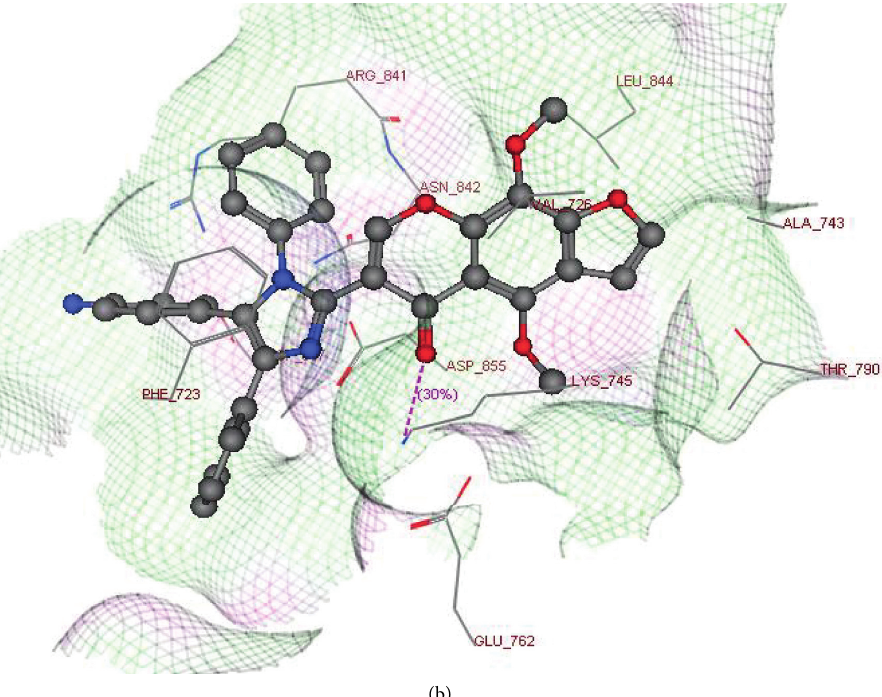
Figure 4: (a) The 2D depiction of the docked conformation of 5c in the EGFR protein (PDB ID: 5CAV) binding site. (b) The 3D depiction of the docked conformation of 5c in the EGFR protein (PDB ID: 5CAV) binding site.